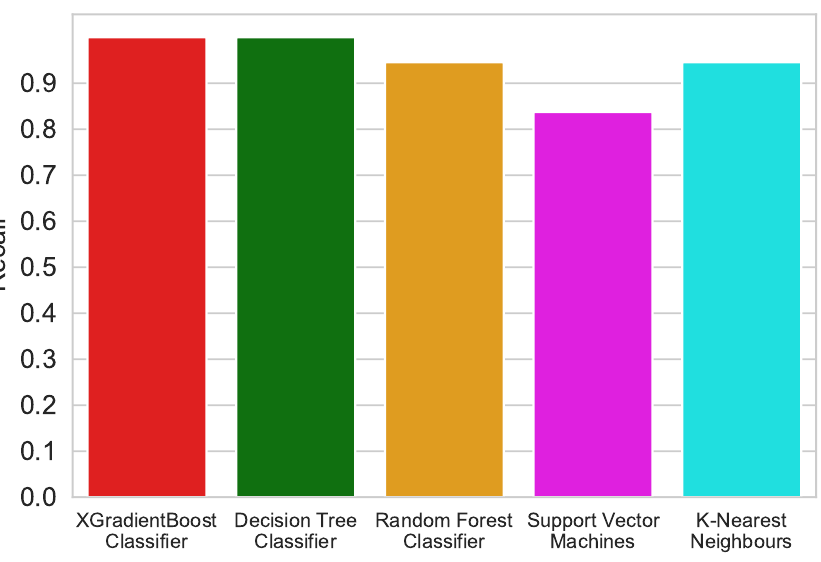
Figure 13. Recall comparison of different algorithms. The receiver operating characteristics (ROC) curve shows the dependence between recall and 1-specificity. It is commonly used in machine learning tasks for medical applica- tions. The closer the curve for a given model is to the point (0,1), the better the classifier. The most common problem in designing models for medical data is that the data contain more healthy cases than disease ones [81]. Figure 14 shows the ROC comparison for each of the algorithms used in this